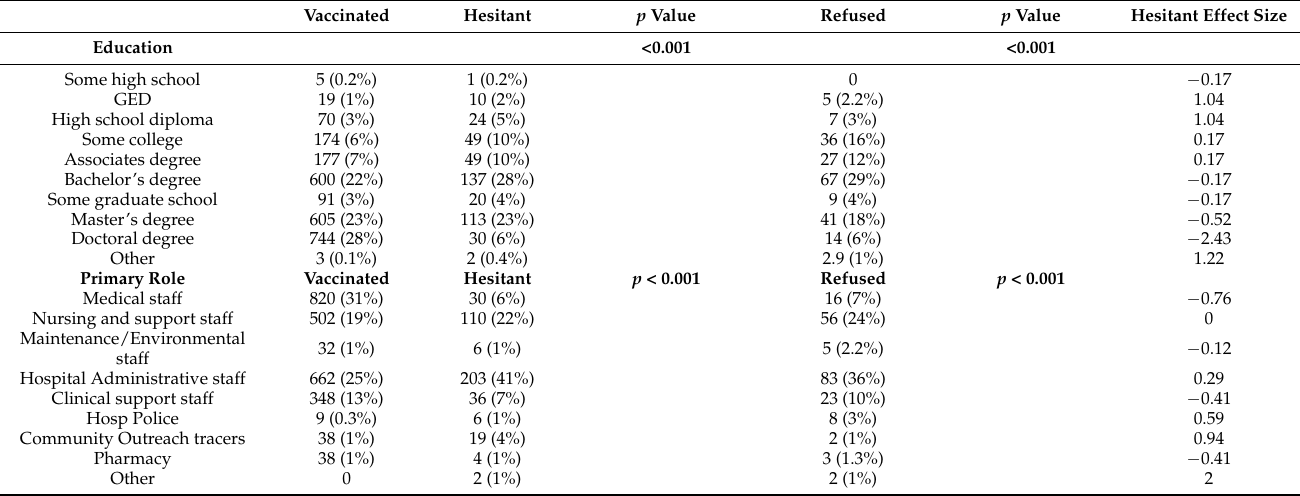
Table 4. Association between education and hospital role with COVID-19 vaccine